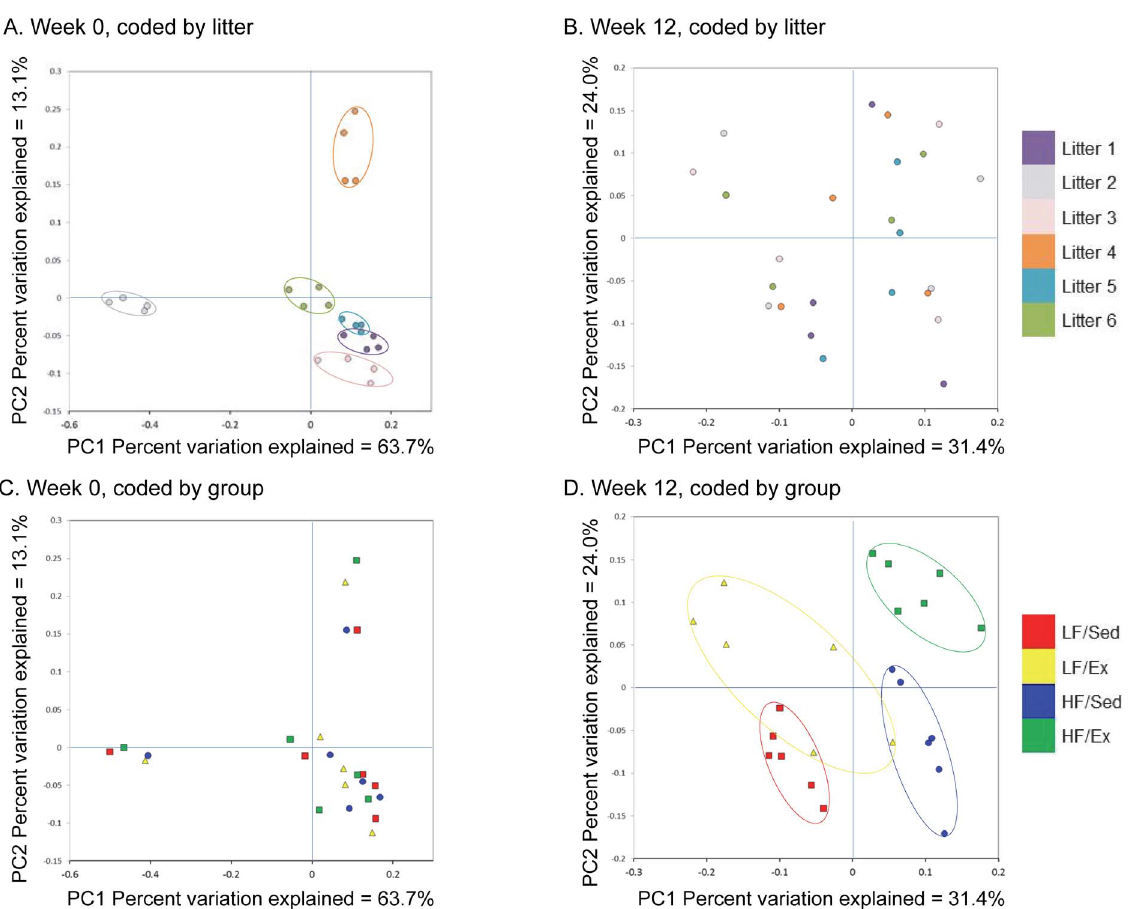
Figure 2. Clustering of Samples Based on Litter, Diet and Activity. Principal coordinate analysis (PCA) was performed based on the weighted UniFrac distance matrix generated from sequencing fecal 16S rRNA gene in samples from mice at week 0 and 12 of the diet and activity protocol. A. Clustering demonstrated by litter at week 0. B. No clustering demonstrated by litter at week 12. C. No clustering demonstrated by diet and activity at week 0. D. Clustering demonstrated by diet and activity at week 12. The top panels show the PCA keyed by litter (6 liters, 1–6, of 4 mice each) and the bottom panels show the PCA keyed by diet and activity group. The X-axis represents the primary coordinate, the Y-axis represents the secondary coordinate. Axis numbering represents the relative distance between samples based on the weighted UniFrac distance matrix.